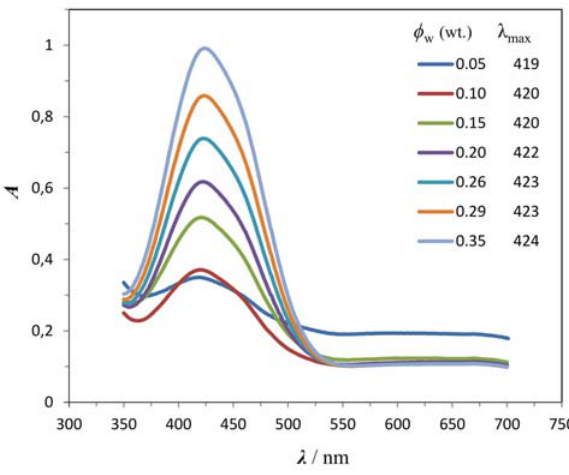
Figure 5. Effect of water content ( φ methyl orange (MO) in microemulsions along the dilution line R = 1.8. The MO concentration is 0.110 mmol L –1